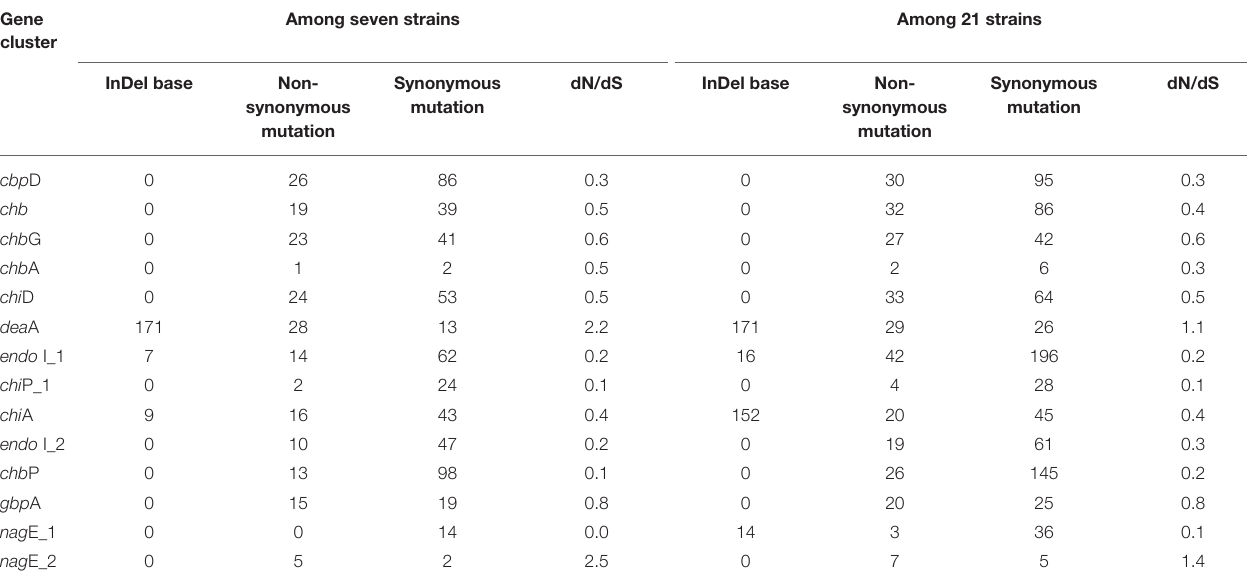
Synonymous synonymous mutation